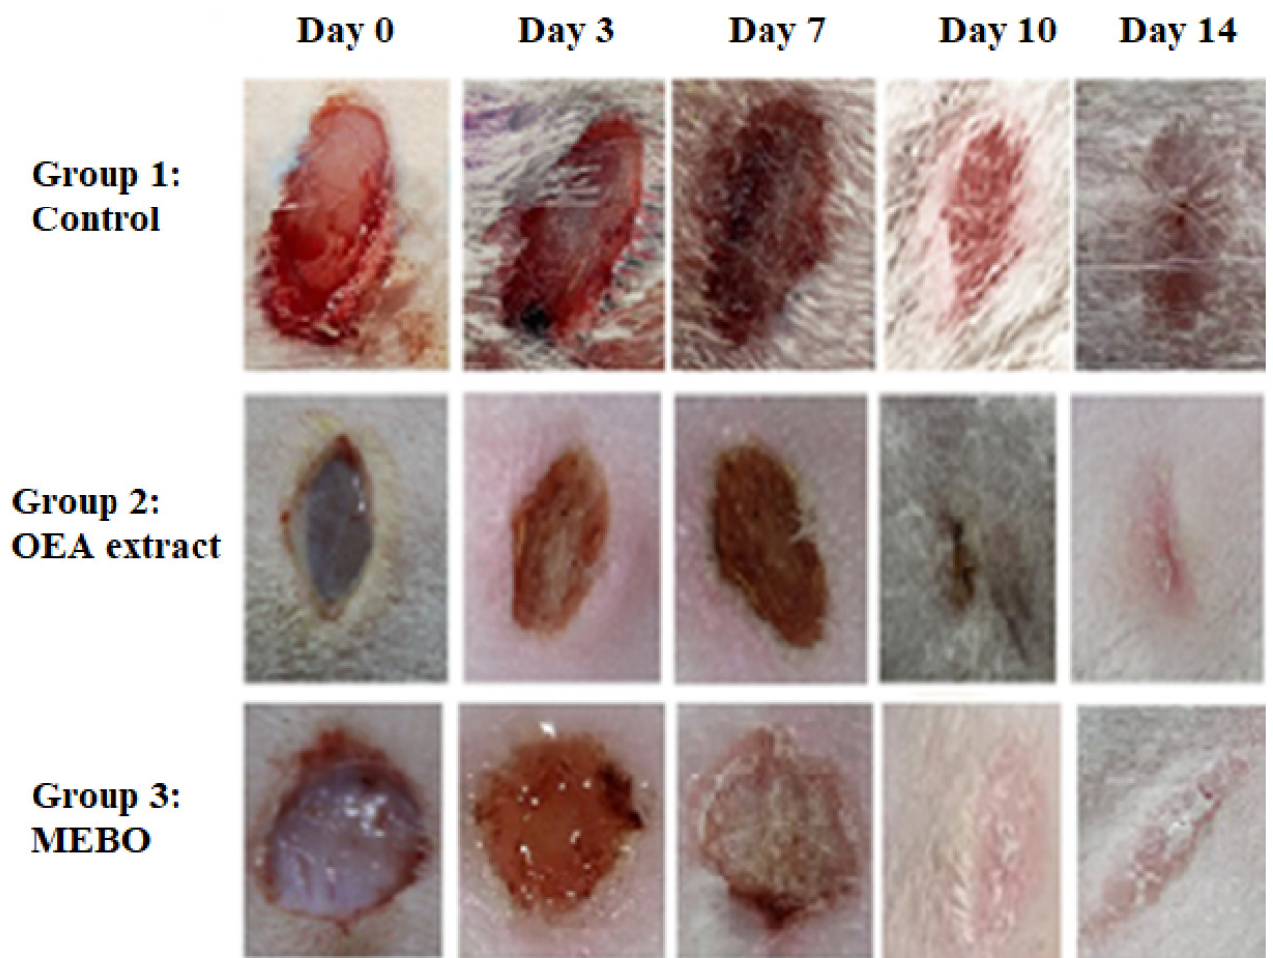
Figure 5. Wound closure rates were calculated using Image J software at various points (0, 3, 7, 10, and 14 days) after injury in each of the three groups ( n = 6).